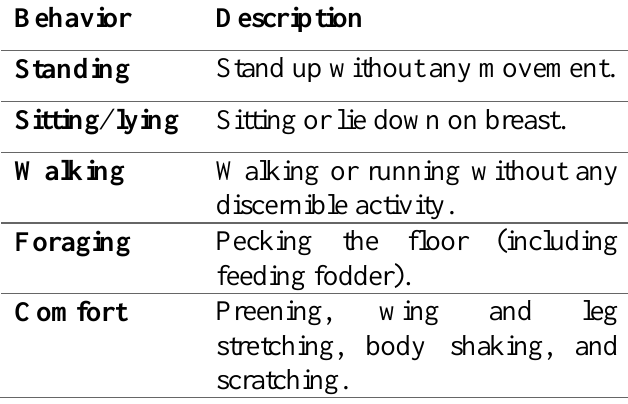
Table 2: Behavior patterns and their description: Behavior